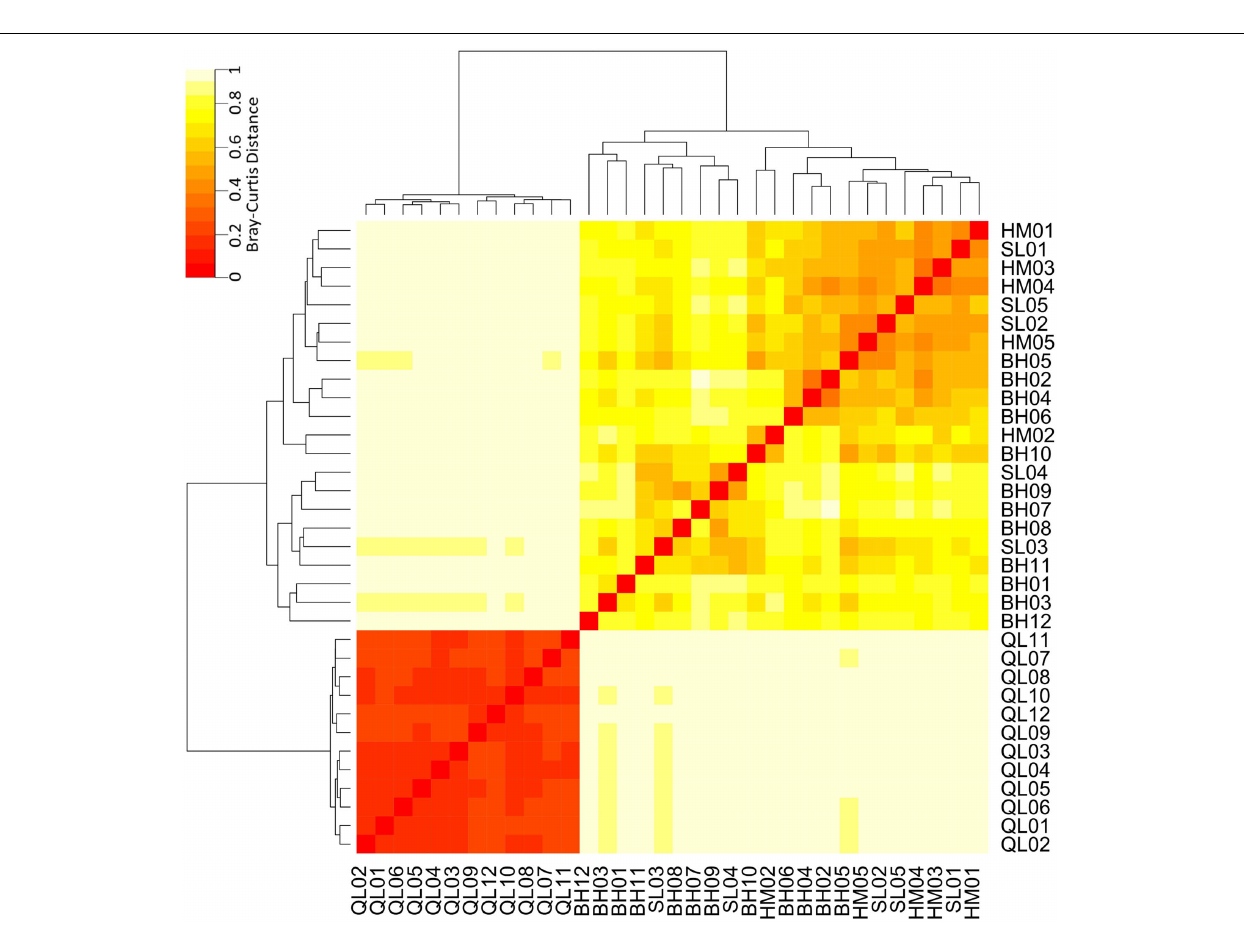
Frontiers in Microbiology |